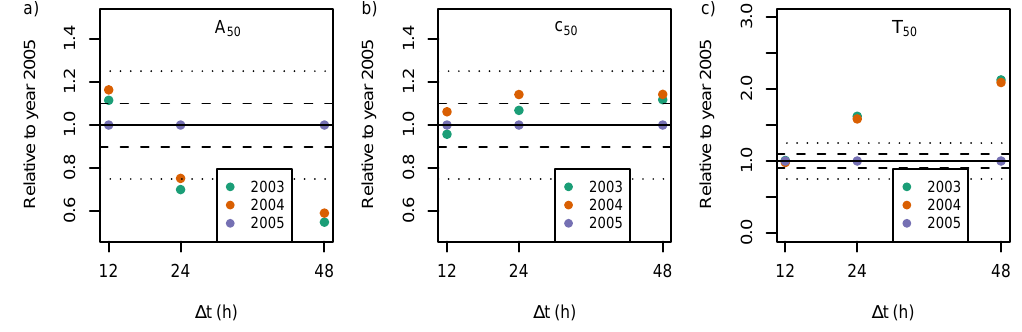
Fig. 7. Annual variability for catchment geometry parameters, (a) area A , (b) circularity c and (c) total annual residence time T as derived for the site Hohenpeissenberg (HPB) and the period